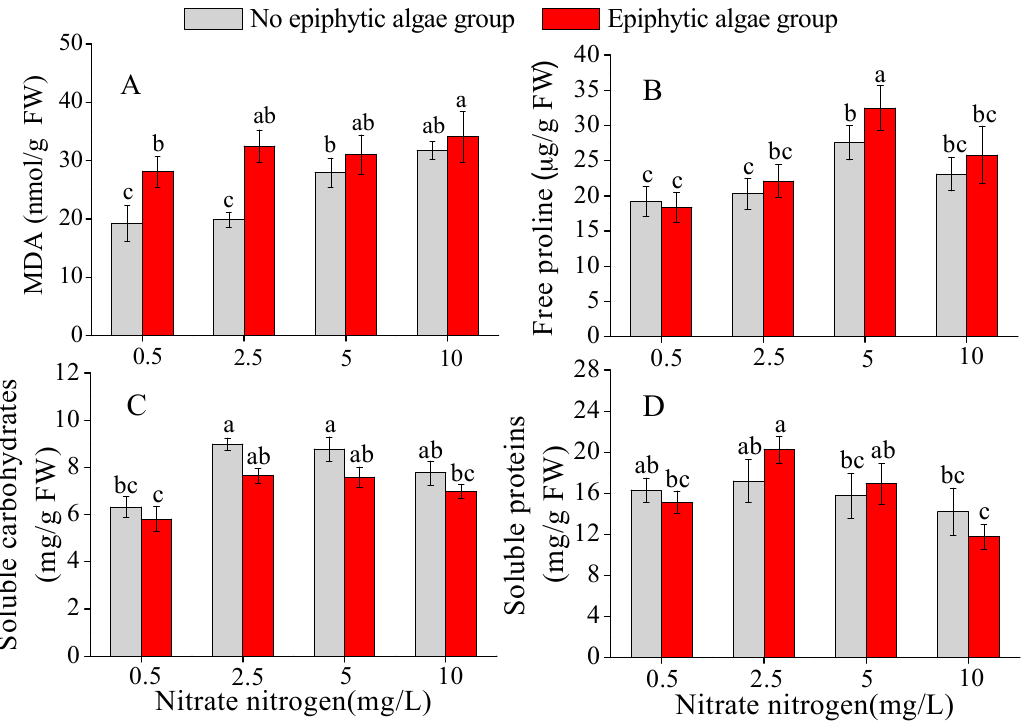
Figure 5. The MDA content ( A ); free proline content ( B ); soluble carbohydrates ( C ); and soluble proteins ( D ) of V. natans (mean ± SE, n = 3) in the epiphytic algae group and no epiphytic algae group under four nitrate-N concentrations. Bars with different letters indicate significant differences among treatments ( p < 0.05).